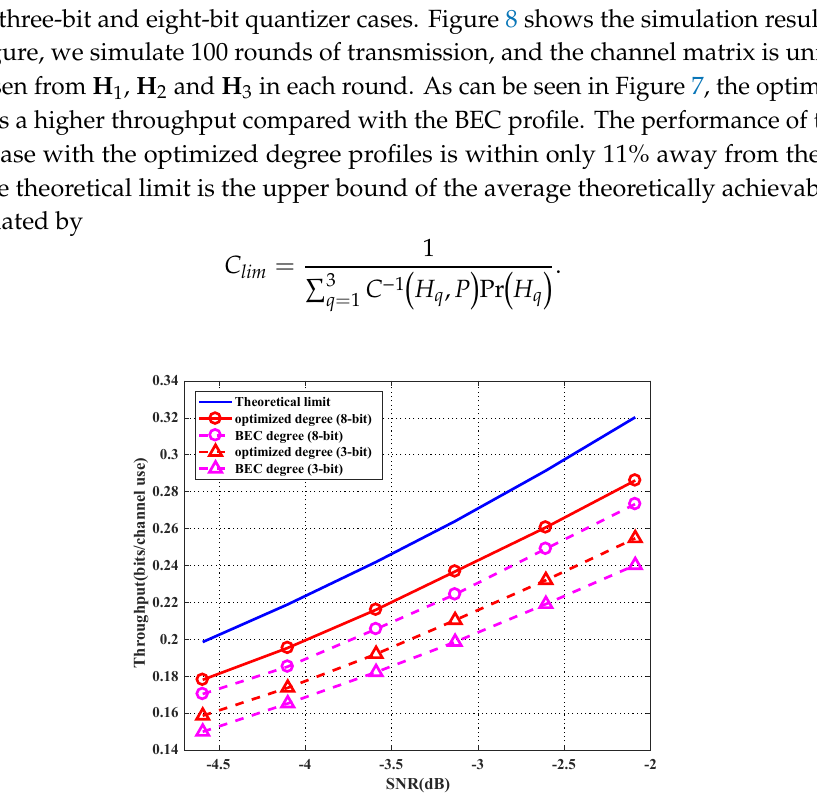
Figure 8. Achieved throughput with the optimized profiles and benchmark profile for the cases of the three-bit quantizer and the eight-bit quantizer.